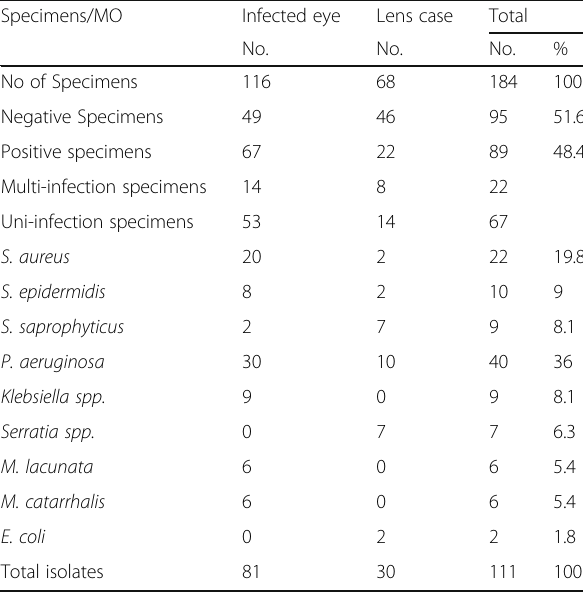
Table 1 The distribution of specimens and type of bacterial